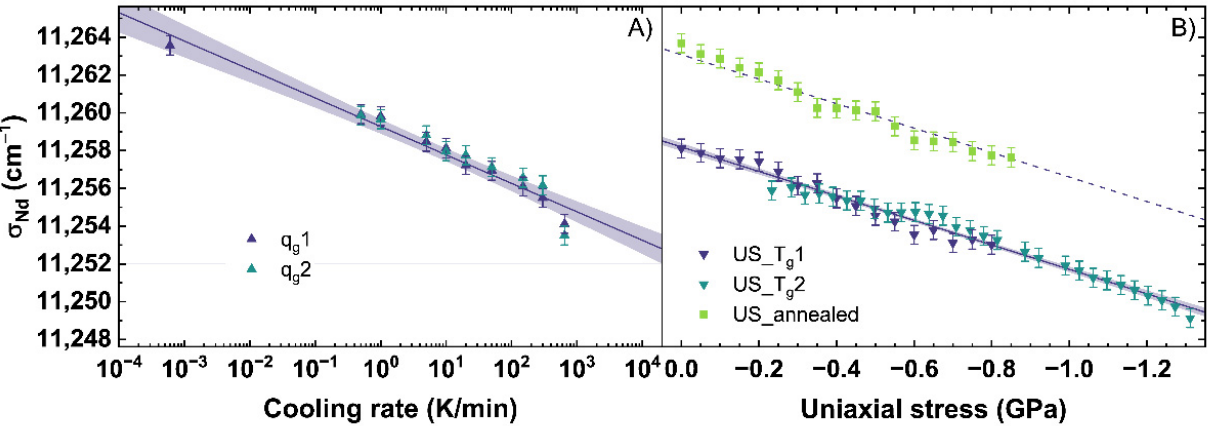
Figure 7. Parameter σ Nd corresponding to the 4 F 3/2 → 4 I 9/2 transition observed under an excitation at 780.42 nm ( A ) versus a change of cooling rate ( q g ) and ( B ) uniaxial stress ( US ). q g 1 and q g 2 are indicated by the dark blue and cyan up triangles. US_T g 1 and US_T g 2 are displayed by the dark blue and cyan down triangles. US_annealed is indicated by light green squares. The shaded areas show the 95% confidence interval of the linear fits.